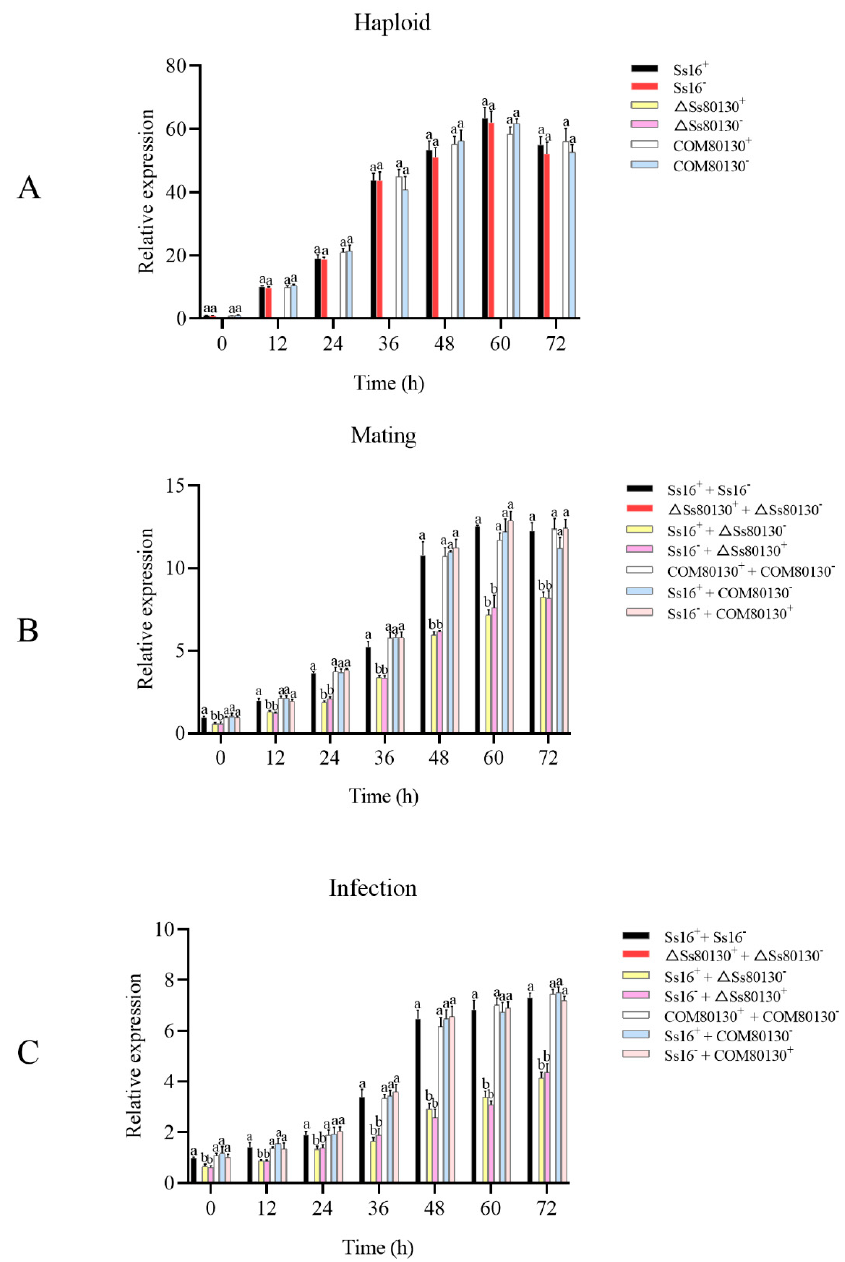
Figure 8. Expression level of the SsCI80130 gene during various stages. ( A ) Gene expression level during haploid sporidial growth. ( B ) Gene expression level during sexual mating culture. ( C ) Gene expression level during sugarcane bud infection. Bars indicate the standard error, and different lowercase letters represent a difference at the 0.05 level.